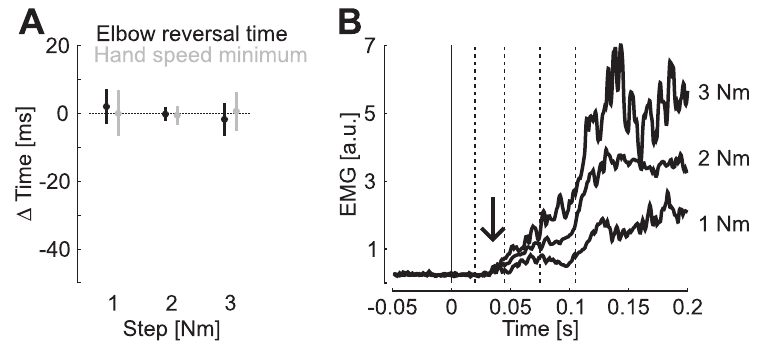
Figure 9. Effect of unexpected changes in perturbation magnitude. A: Reversal times and hand speed minima across the tested values of step magnitudes as presented in Figure 4 C. We used the same scale as in Figure 4 C to emphasize that unexpected changes in step magnitude could not account for the effect of ramp profiles on the times of reversal or hand speed minima. B: Perturbation evoked response from Brachioradialis averaged across subjects. The vertical arrows illustrate the latest onset of divergence across all pair wise comparisons based on ROC analysis (35